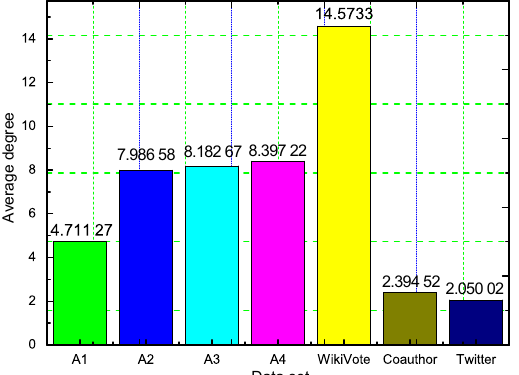
Fig. 10 Average degree of each real-world data